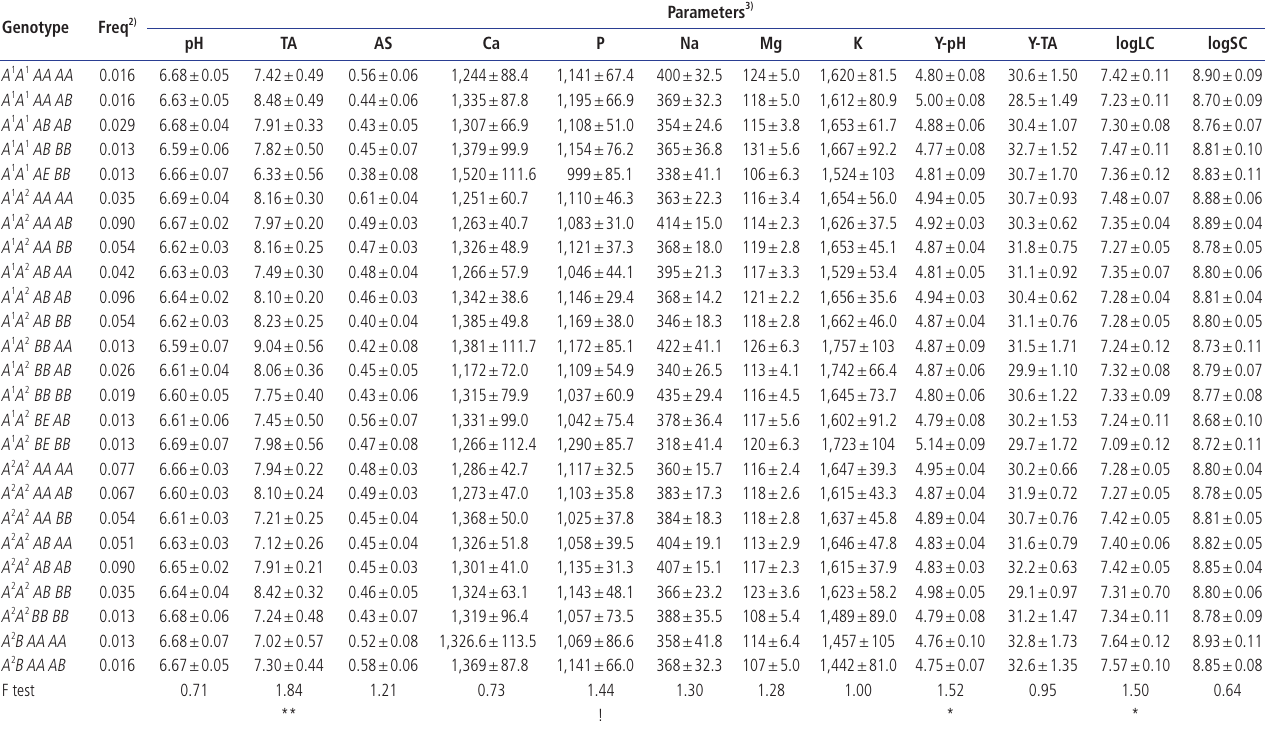
Table 5. The relation between composite CSN2 – CSN3 – LGB genotype and physiochemical and fermentation ability parameters 1)